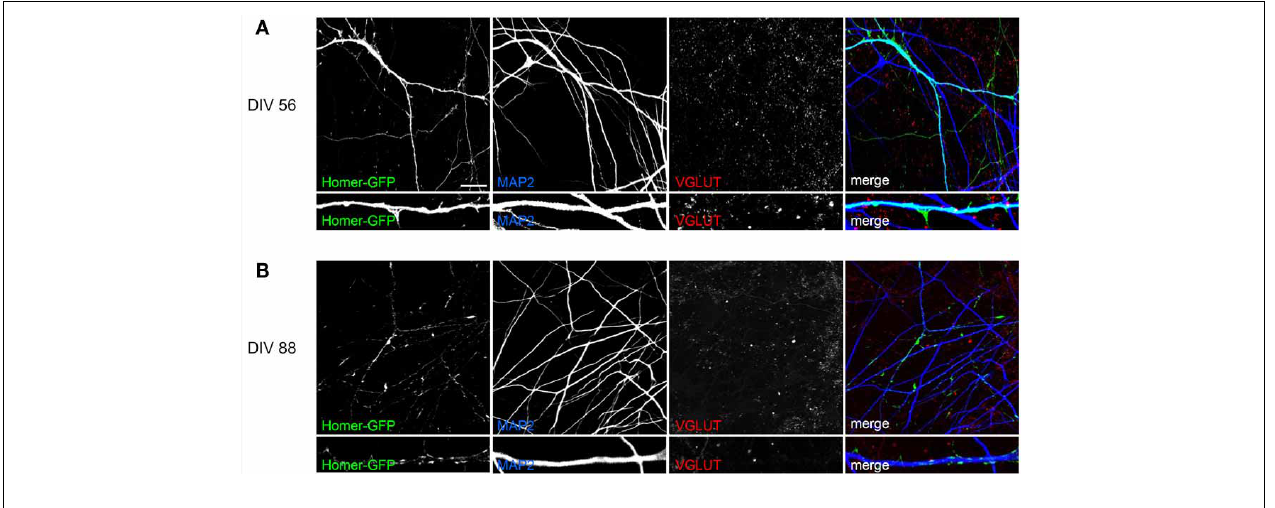
FIGURE 8 | Characterization of postsynapse formation in hNP-derived neurons differentiated by co-culture on E18 rat primary cortical neurons. (A) After 56 days in co-culture, hNP-derived neurons are positive for MAP2 but the Homer-GFP